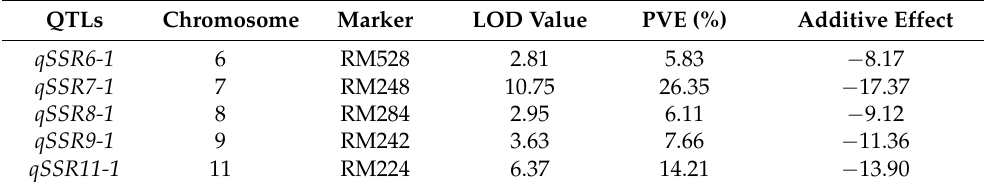
Table 4. QTLs for seed-setting rate of rice under high temperature detected in CSSLs